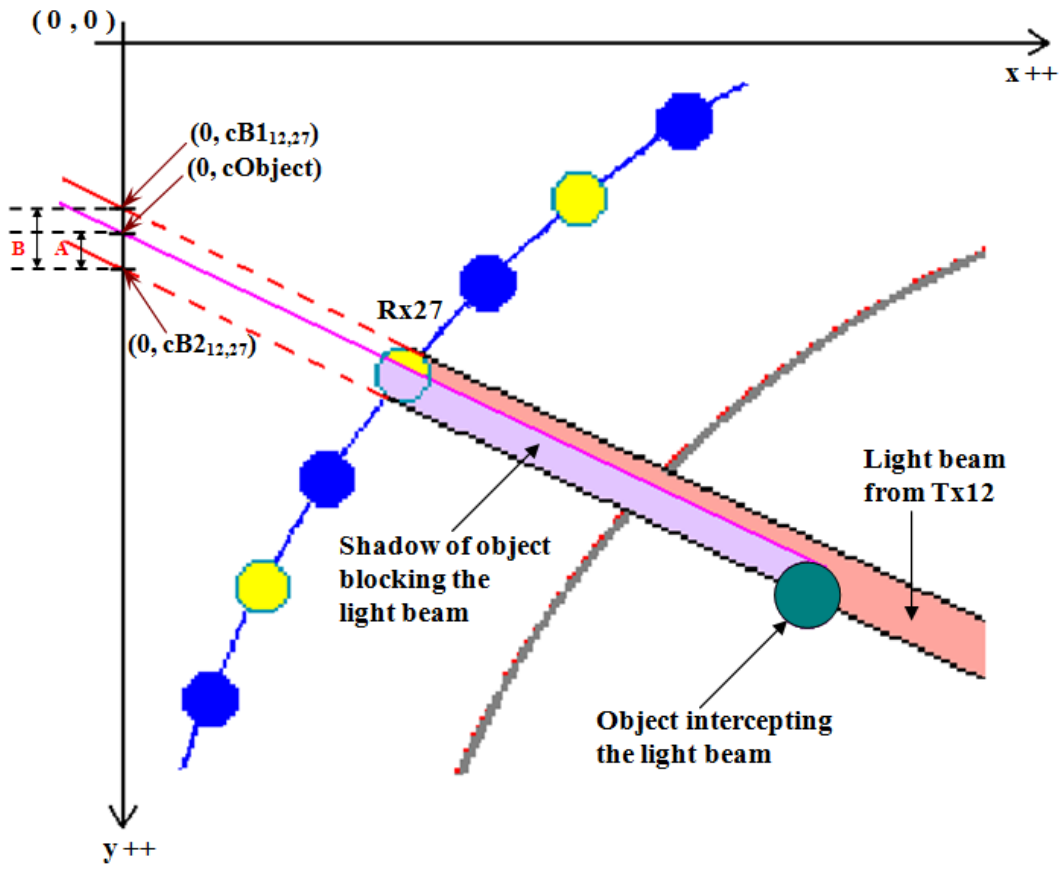
Figure 4. An example of an object intercepting a light